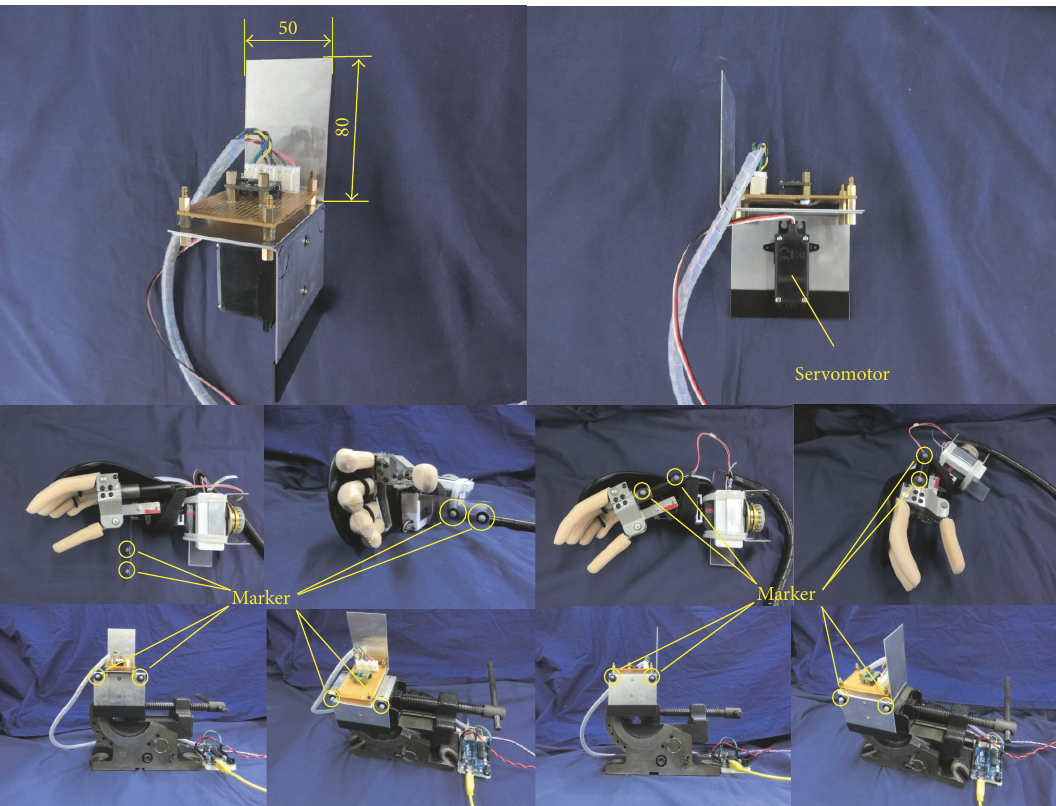
Figure 6: Angle representation device and marker positions.